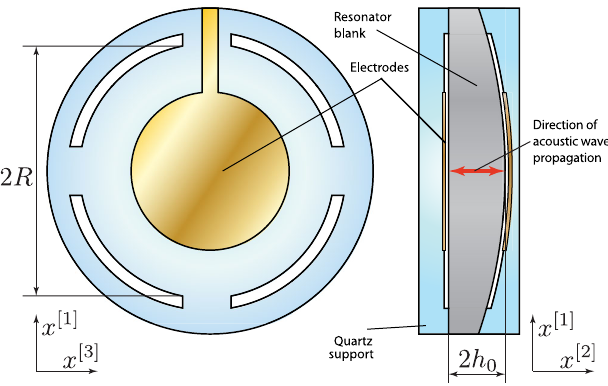
FIG. 5. Schematic view of a BVA (boîtier à vieillissement amélioré, enclosure with improved aging) BAW quartz resonator. The vibrating quartz body, resonator blank, is held by a quartz support deposited electrode. The resonator is fabricated in a plano-convex geometry that traps vibration in the disk center. Electrodes are deposited on the support and separated from the . t plank by a small vacuum . t